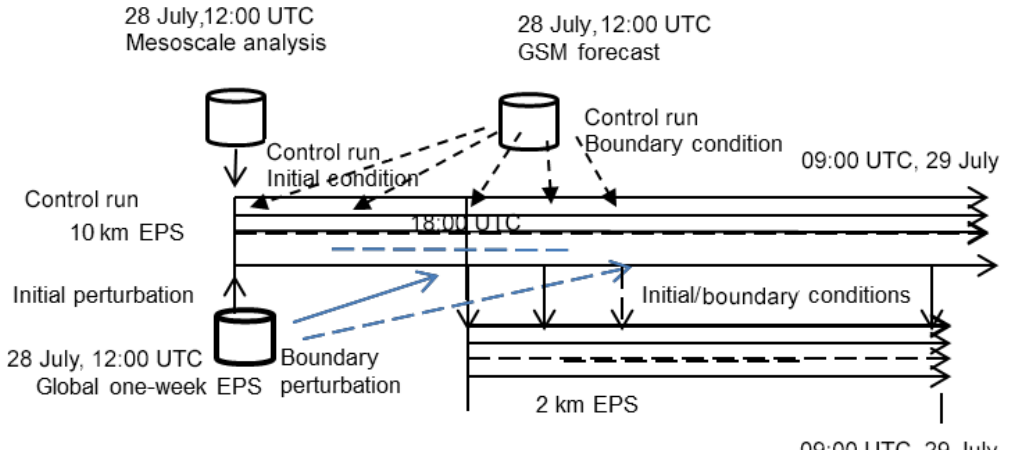
Figure 8. Schematic of the 10 and 2km